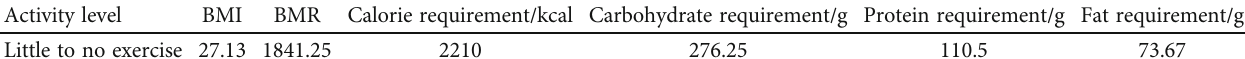
Table 8: Sample user data with daily calorie and macronutrient requirements.